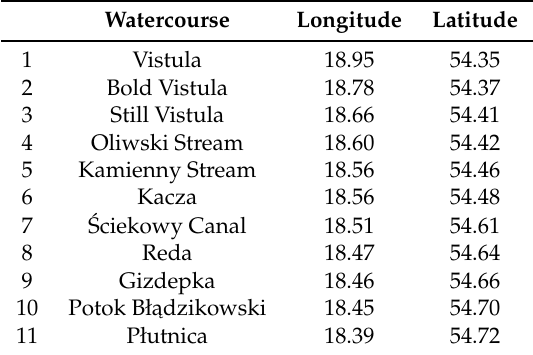
Table 1. Locations of mouths of watercourses included in the EcoPuckBay model domain.